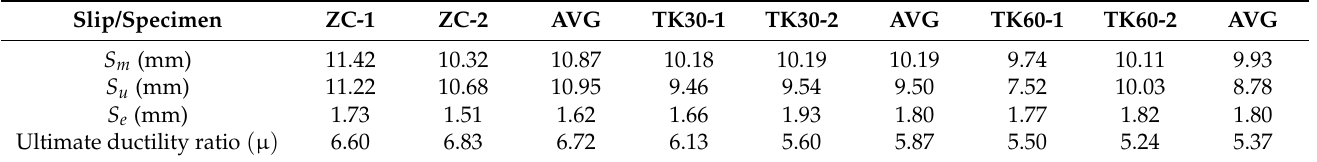
Table 6. Ductility of